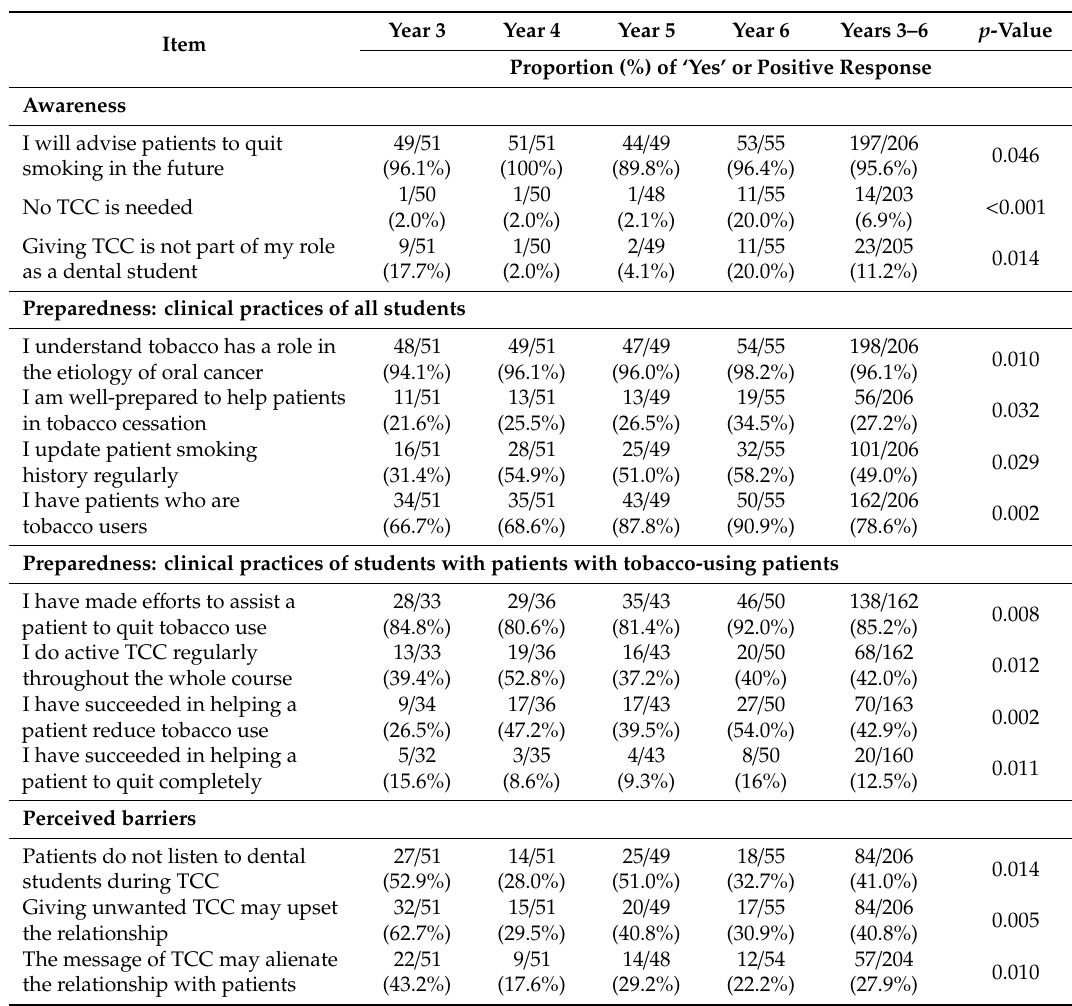
Table 4. Variations of awareness, preparedness and perceived barriers towards tobacco cessation counselling (TCC) of Hong Kong dental